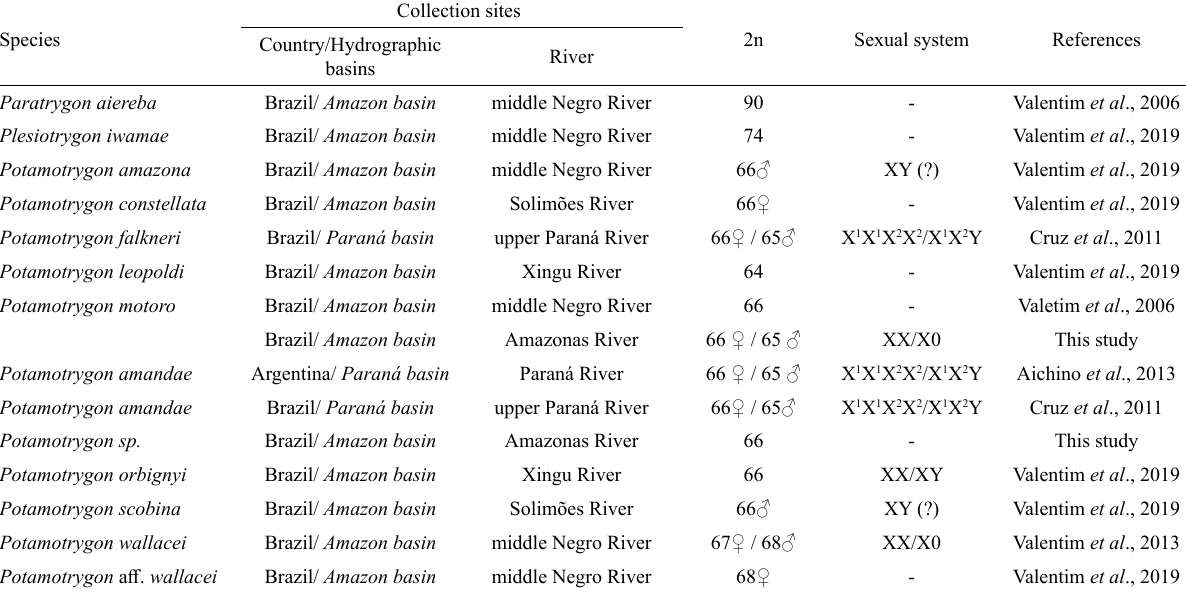
Table 1 – Summary of karyotypes information for the freshwater stingrays. 2n = diploid